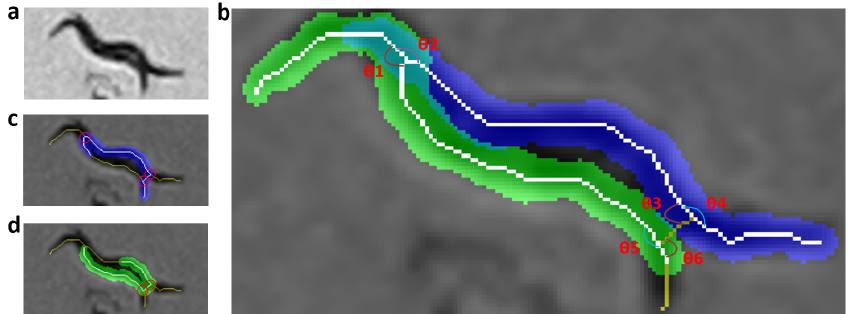
Figure 7. Smoothness criterion evaluation. The yellow and white pixels are the resulting skeleton using the improved skeletonizing method. The white pixels are the pixels of the skeleton prediction, which are used to reconstruct the body of each worm (segmentation in blue and green). ( a ) Grayscale image. ( b ) Evaluation of smoothness, angles in red are those that have more weight and increase the index of smoothness. ( c ) Incorrect prediction of worm1 with high softness criterion. ( d ) Incorrect prediction of worm2 with high softness criterion.